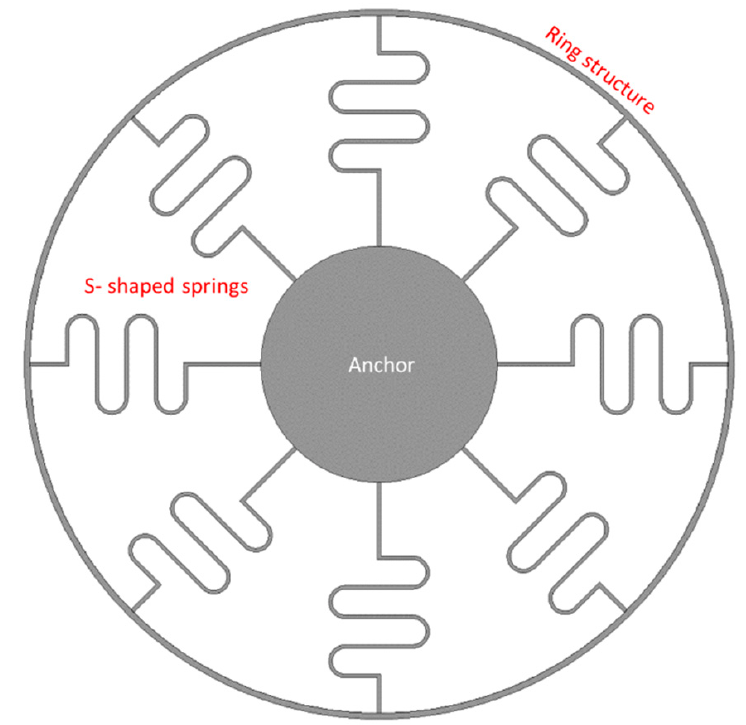
Figure 16. Schematic view of eight S-shaped support springs in a vibrating ring